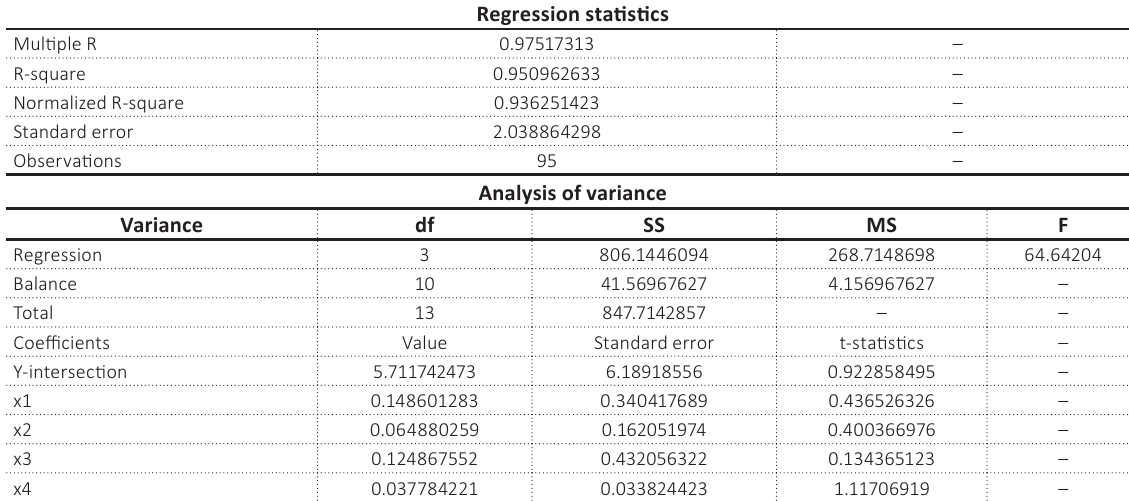
Table 4. Summary of regression analysis results of the dependence of bank capital to assets ratio on macroeconomic